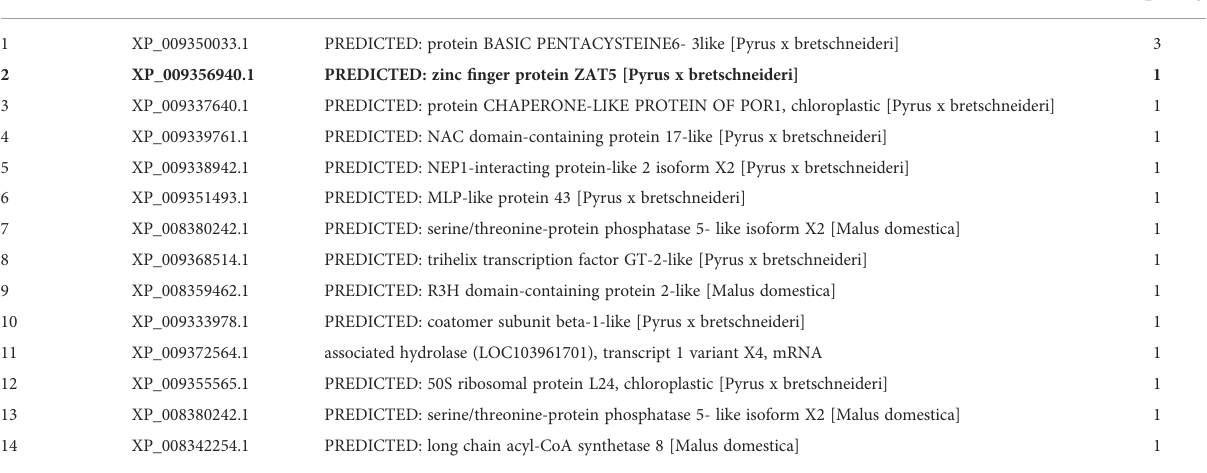
TABLE 1 Screening results of PpBBX18 promotor transcriptional